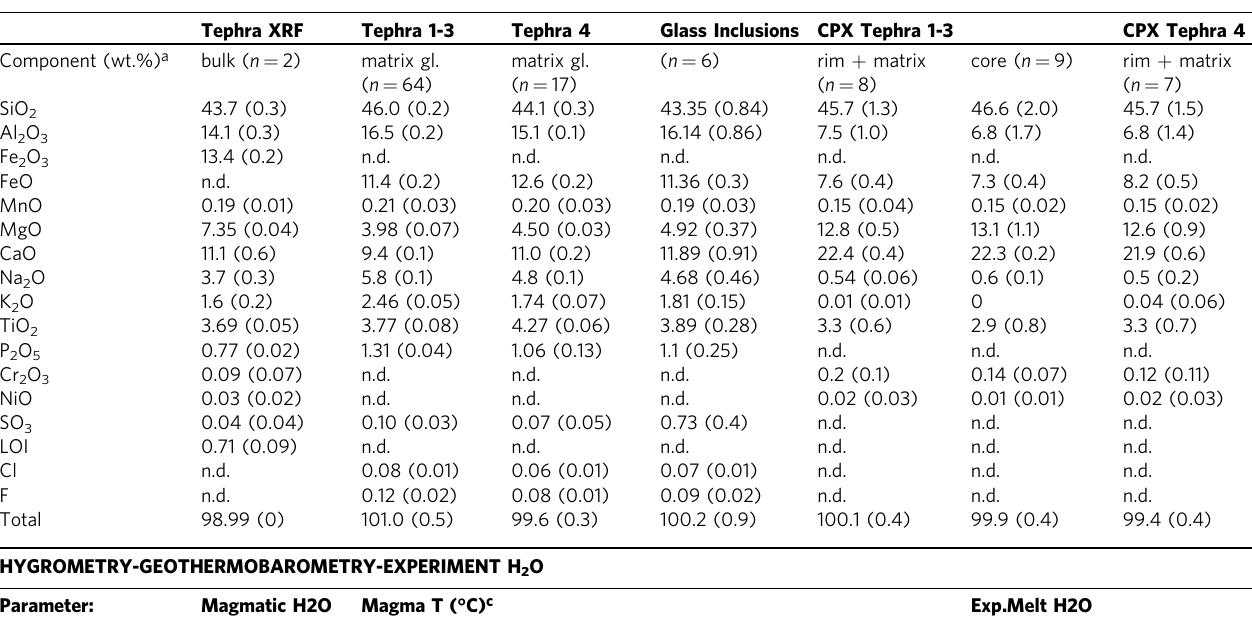
Table 1 Major element compositions and thermo-rheological properties of basanite from the 2021 eruption of Cumbre Vieja, La